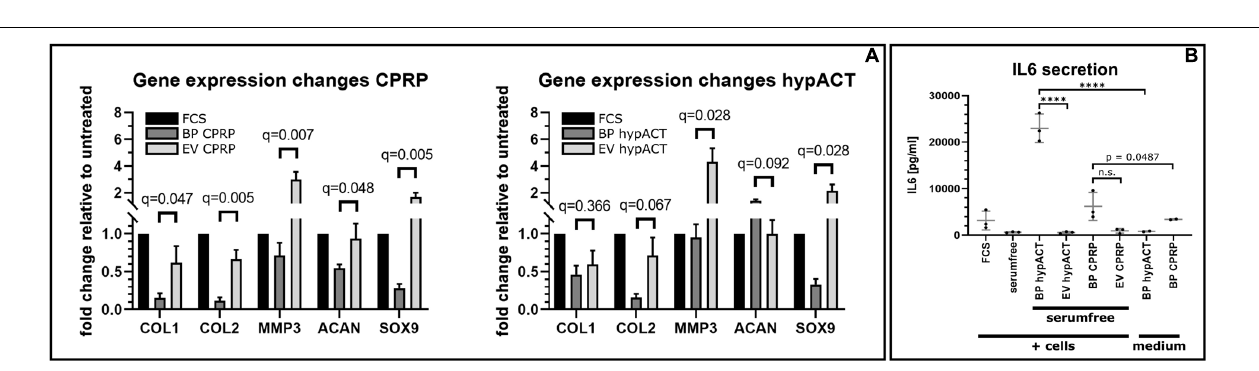
FIGURE 5 | Gene expression changes mediated by citrate-anticoagulated platelet-rich plasma (CPRP) and hyperacute serum (hypACT) blood products (BP) and EVs in patient derived chondrocytes relative to untreated cells. Data are given as arithmetic mean of triplicate measurements ± SE of 4 individual chondrocyte donors.